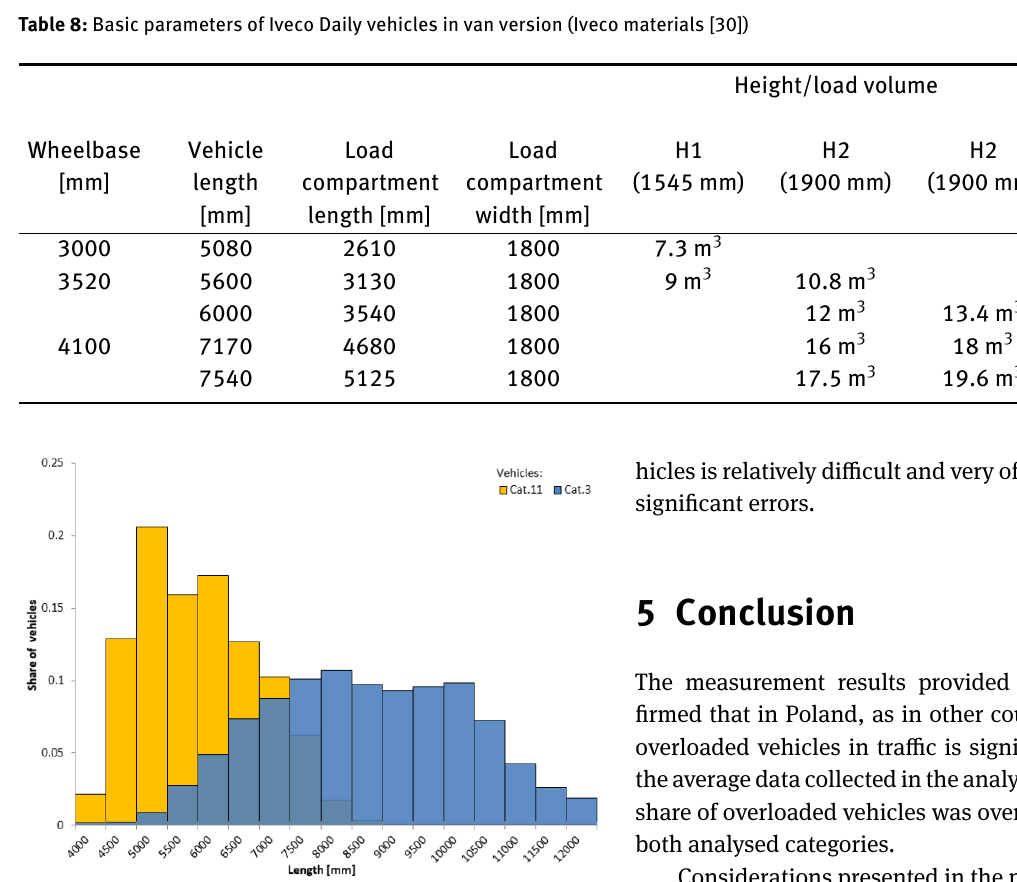
Figure 10: Length distribution of category 3 and 11